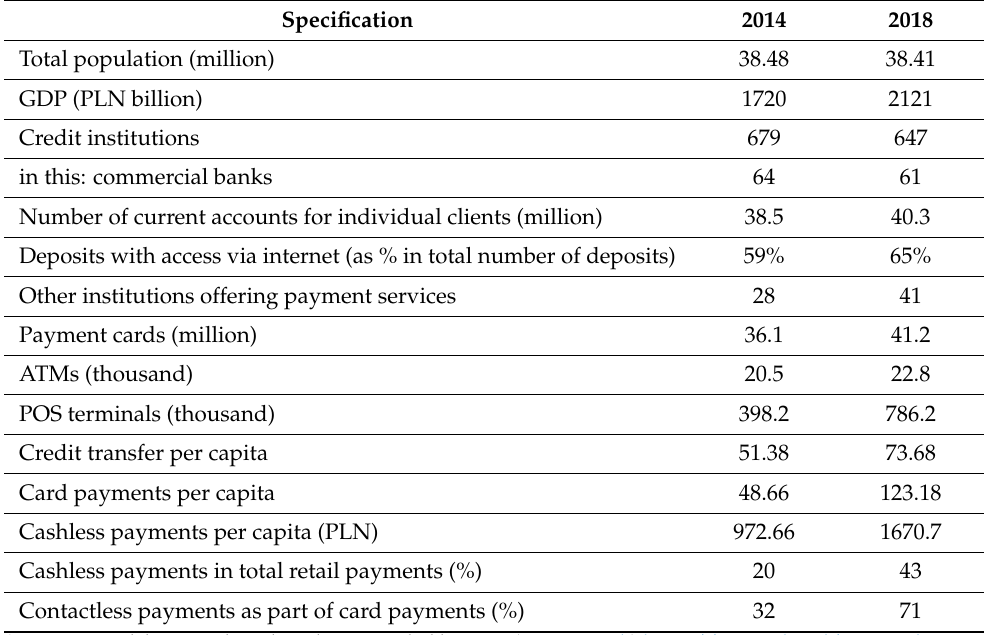
Table 3. Selected macroeconomic and retail payment system data characteristics for